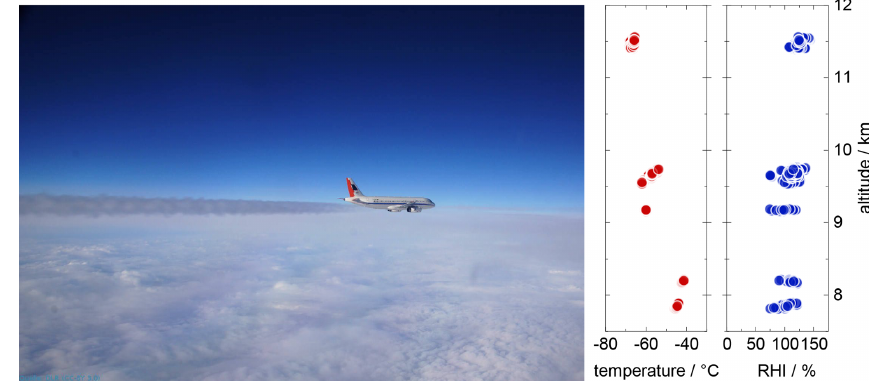
Figure 1. The DLR A320 with contrail in January 2018 during the ECLIF II/NDMAX flight experiment. Source of photograph: DLR (CC- BY 3.0 DE). The plots show plume encounter mean values of the temperature and the relative humidity with respect to ice (RHI) versus altitude adapted from Bräuer et al. (2021). Table 1. Properties and sample statistic of jet fuels burned during ECLIF II/NDMAX.